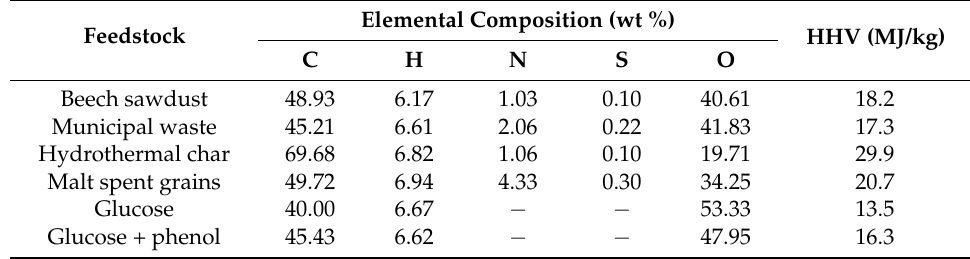
Table 1. Elemental analysis and higher heating value (HHV) of the feedstock. HHVs were calculated by means of the Dulong-Petit correlation (see Section